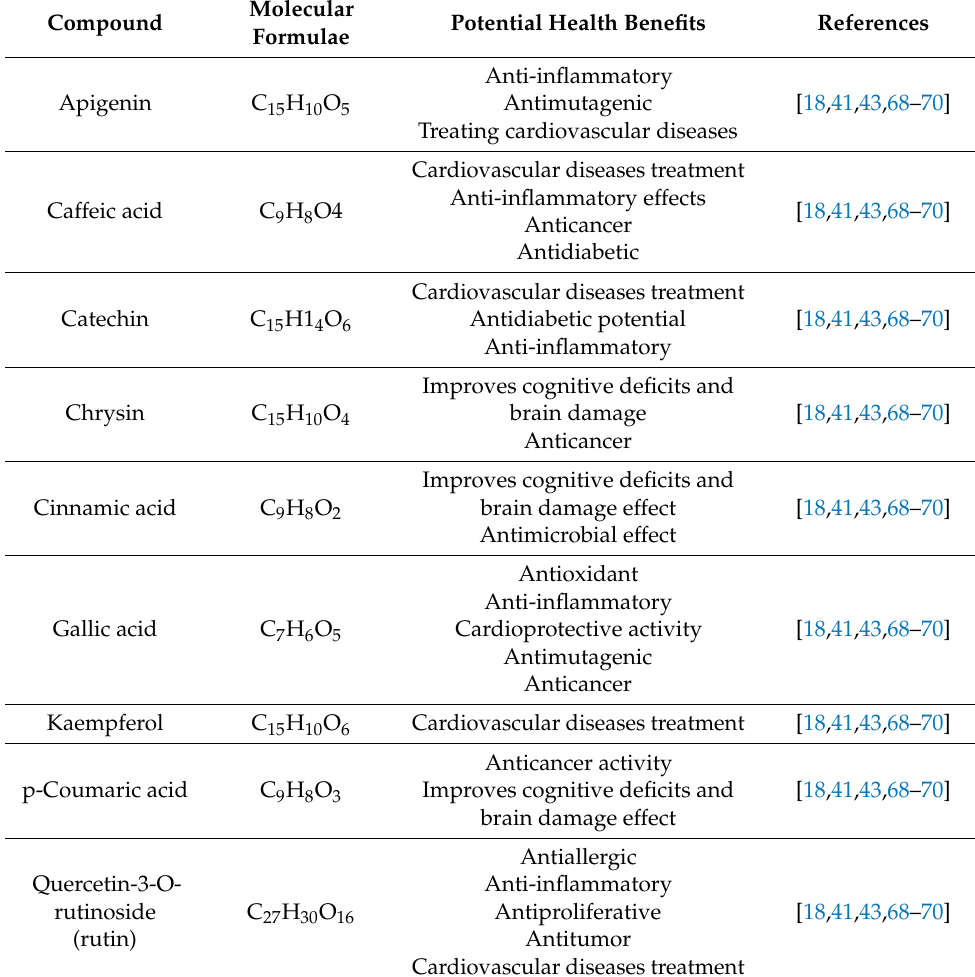
Table 3. Some of phenolic compounds with their potential health benefits found in MH, TH, KH, and